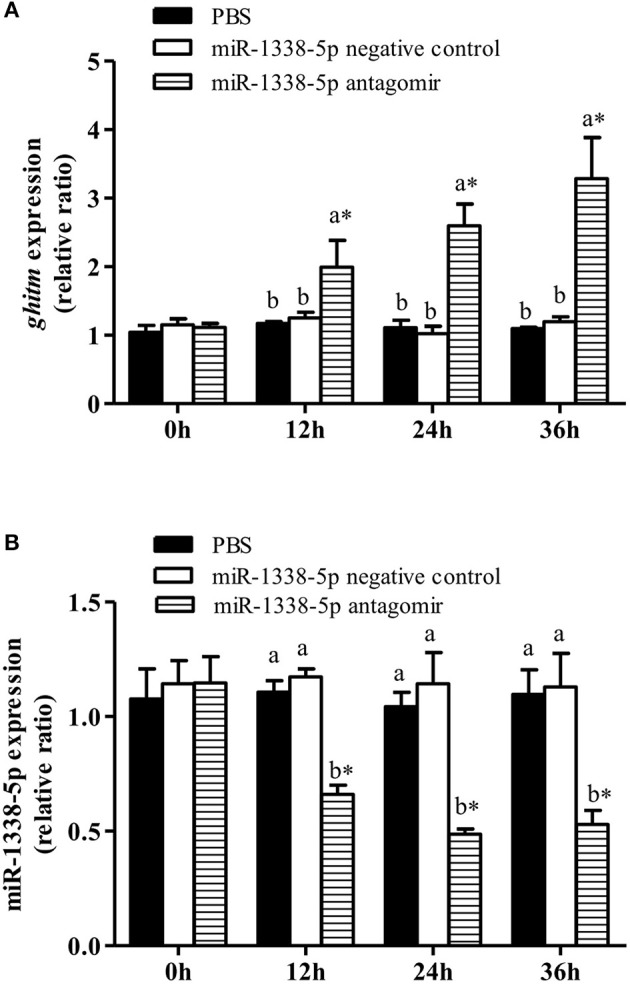
Effect of inhibiting miR-1338-5p on the expression of miR-1338-5p and ghitm in GIFT liver over a 36 h period. Juvenile GIFT weighing about 5.4 g received a tail-vein injection of PBS, miR-1338-5p negative control, or miR-1338-5p antagomir at a dose of 50 mg kg−1 body weight. qRT-PCR analysis was used to detect the relative expression of ghitm
(A) and miR-1338-5p (B) (n = 9–12 fish per group). The GIFT injected with PBS were taken as the control. *P < 0.05 indicates significant differences between values of each treatment obtained before and after injection by paired-samples t-test. Diverse lowercase letters show significant differences (P < 0.05) in different treatments of each sampling point by Duncan's multiple range test. Fold changes in expression levels were normalized against the pre-treatment sampling point of PBS group.